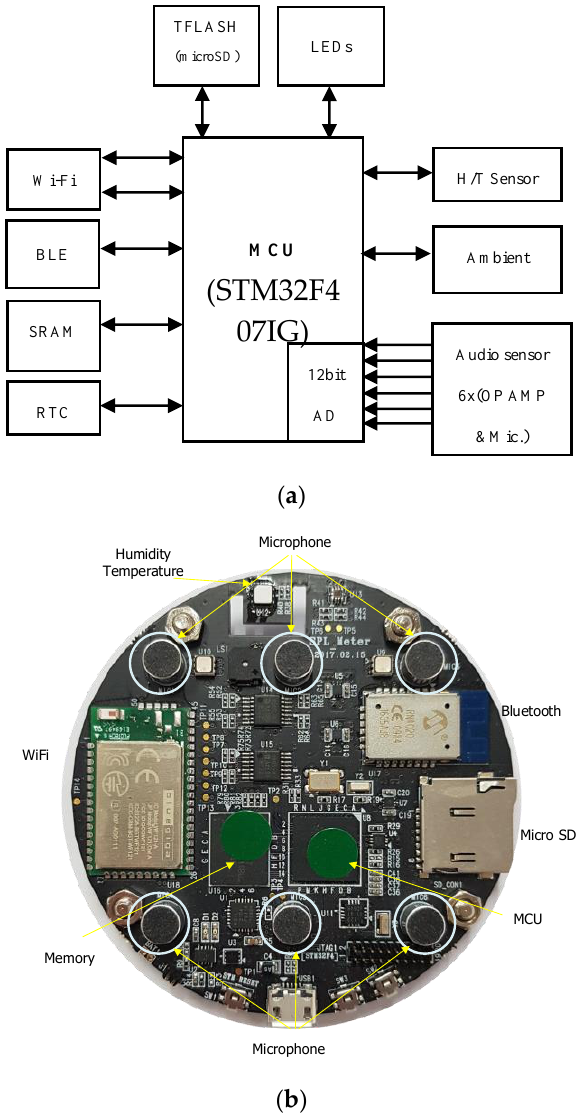
Figure 2. Sensor board of the system: ( a ) block diagram and ( b ) hardware prototype.